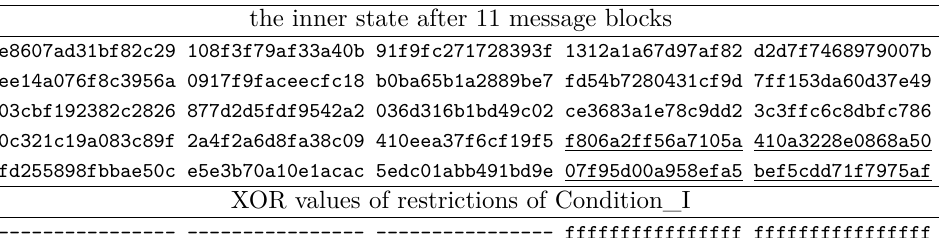
Table 6: The inner state H (in little-endian order).